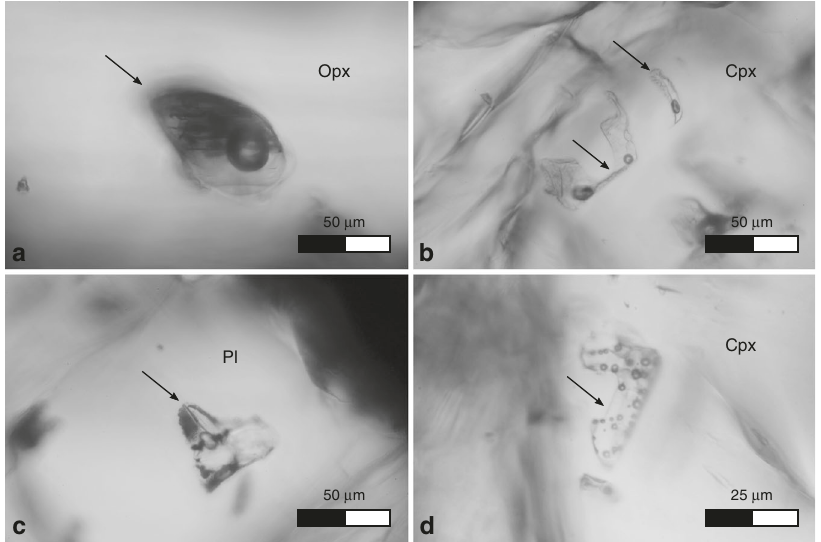
Fig. 2 Representative bubble-bearing melt inclusions at transmitted light optical microscopy. The black arrows indicate the bubble-bearing melt inclusions. a Single-bubble MI hosted in orthopyroxene (Opx; sample NS21, Nova Scotia, Canada). b Single- and multi-bubble MIs, with very irregular shapes, hosted in augitic clinopyroxene (Cpx; sample AN137A, Morocco). c Multi-bubble MI, partially crystallized (containing also opaque mineral phases), hosted in calcic plagioclase (Pl; sample NS9, Nova Scotia, Canada). d Multi-bubble MI hosted in augitic clinopyroxene (Cpx; sample NS9, Nova Scotia,